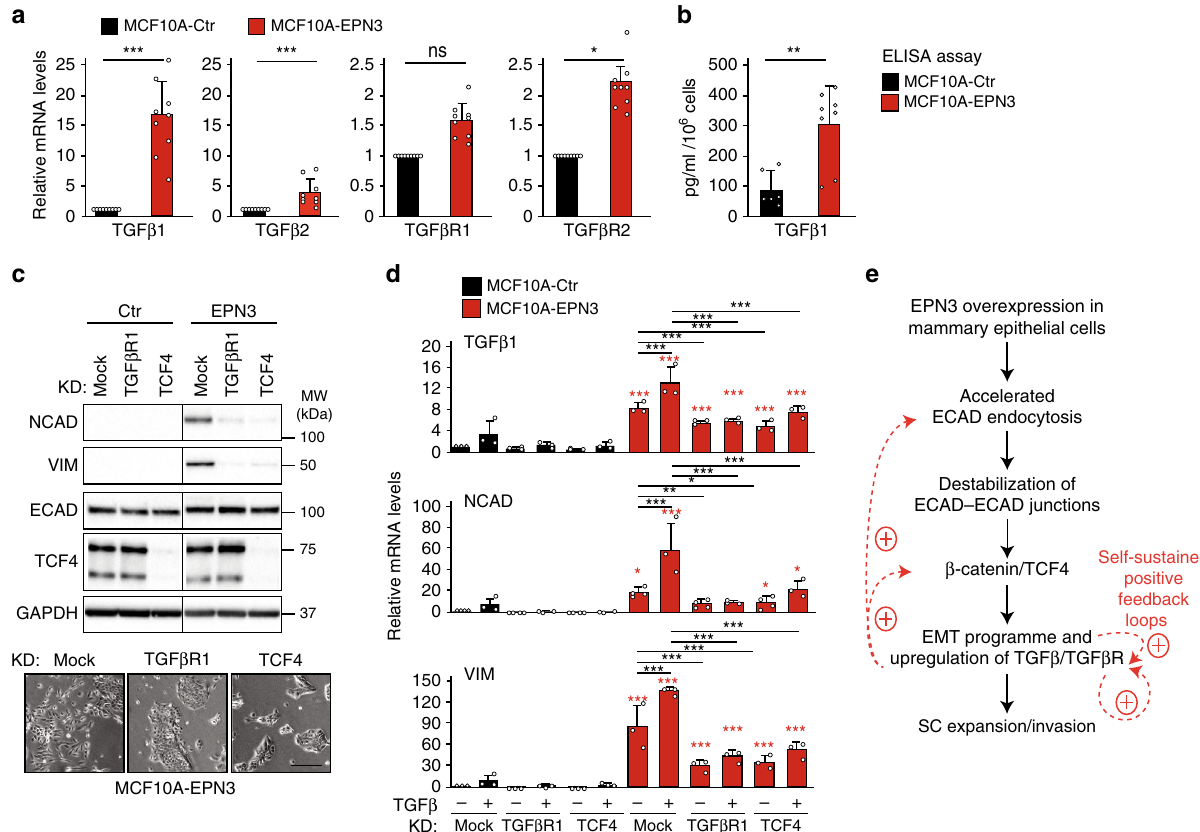
Fig. 6 EPN3-driven partial EMT relies on a TGF β -based autocrine loop. a RT-qPCR analysis of mRNA expression of TGF β ligands (TGF β 1, TGF β 2) and receptors (TGF β R1, TGF β R2) in MCF10A-Ctr and -EPN3 cells. Mean relative mRNA expression compared with MCF10A-Ctr ± S.D. of nine independent experiments, each performed in technical triplicates. P value, Student ’ s t test two-tailed. b ELISA assay of secreted TGF β 1 in conditioned media from MCF10A-Ctr and -EPN3 cell cultures. Results are reported as pg ml − 1 10 − 6 cells ± S.D. ( n = 3, each performed on the medium of at least two independent dishes, each assayed in technical triplicates). P value, Student ’ s t test two-tailed. The same data are also reported in Supplementary Fig. 8A top for comparison between MCF10A-Ctr, -EPN3, -EPN1, and -TWIST. c Top, TCF4 or TGF β R1 were silenced in the indicated cells. Mock transfection was used as negative control. Cell lysates were IB with the indicated Ab. This panel was assembled from samples run on the same gel by splicing out the irrelevant lanes (as shown by the black lines). GAPDH, loading control. Right, MW markers. Relative protein levels of NCAD, ECAD and VIM of this blot were quanti fi ed together with other experiments (see Supplementary Fig. 8C for quantitation and statistics). Bottom, representative phase-contrast microscopy of MCF10A-EPN3 cells, mock, TCF4 KD or TGF β R1 KD. Bar, 250 µ m. d RT-qPCR analysis of mRNA expression of the indicated genes in MCF10A-Ctr and -EPN3 cells that were mock-treated or subjected to TGF β R1 KD or TCF4 KD, and stimulated or not with TGF β 1 (5 ng ml − 1 , 48 h). Results are reported as relative mRNA expression compared with the MCF10A-Ctr mock-treated sample, mean ± S.D. ( n ≥ 3, each performed in technical triplicates). P value, each pair Student ’ s t test, two-tailed. Black asterisks, statistical signi fi cance between KD samples vs. mock, not treated, and KD samples vs. mock, treated with TGF β 1, as indicated by the bar; red asterisks, statistical signi fi cance between matched MCF10A-EPN3 samples vs. -Ctr samples. e Proposed model of the EPN3-dependent activation of the EMT program in mammary epithelial cells. Source data are provided as a Source Data fi